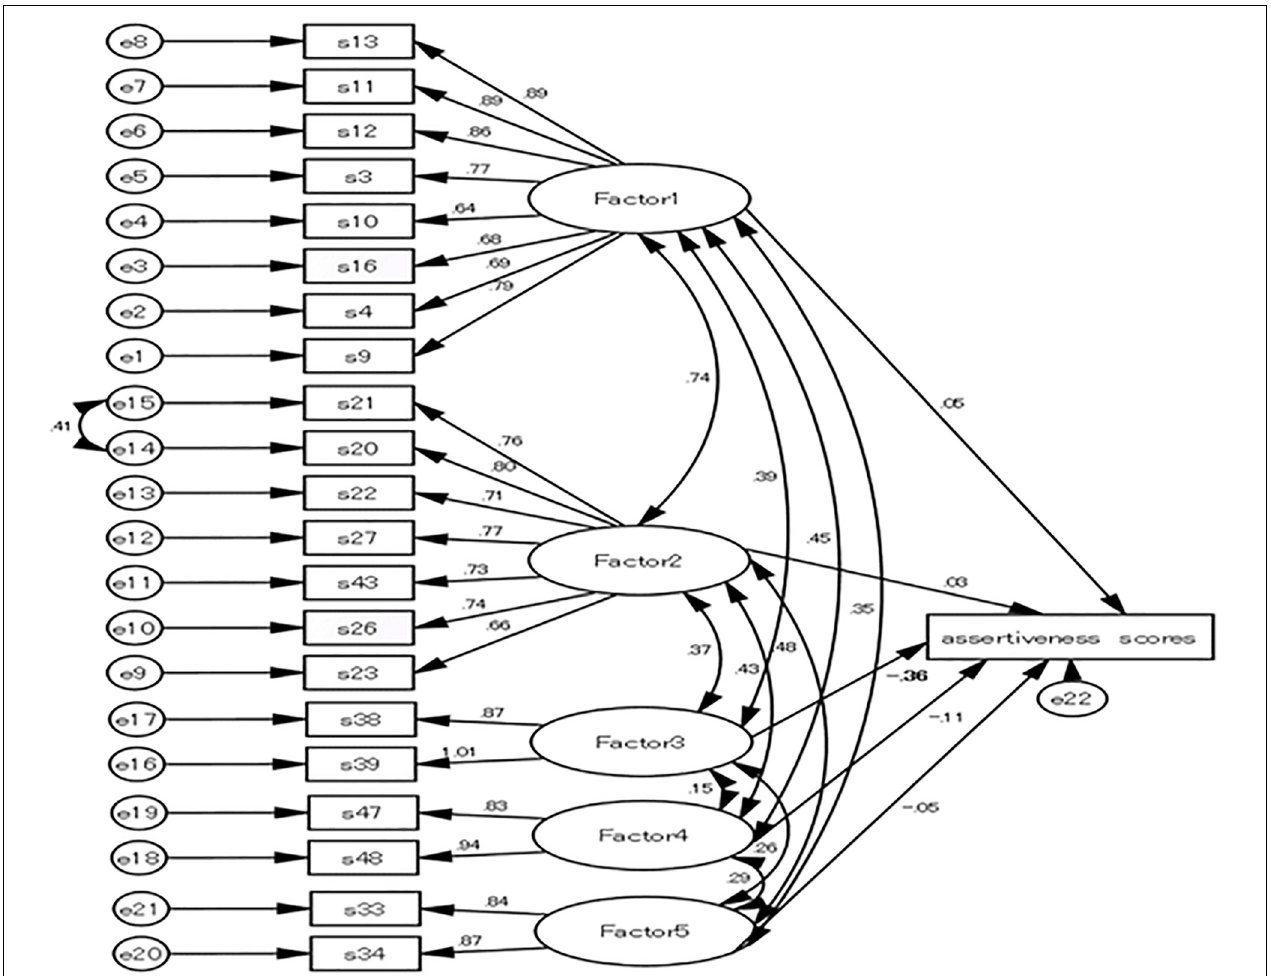
FIGURE 1 | Relations between stressors when caring for children with special needs and